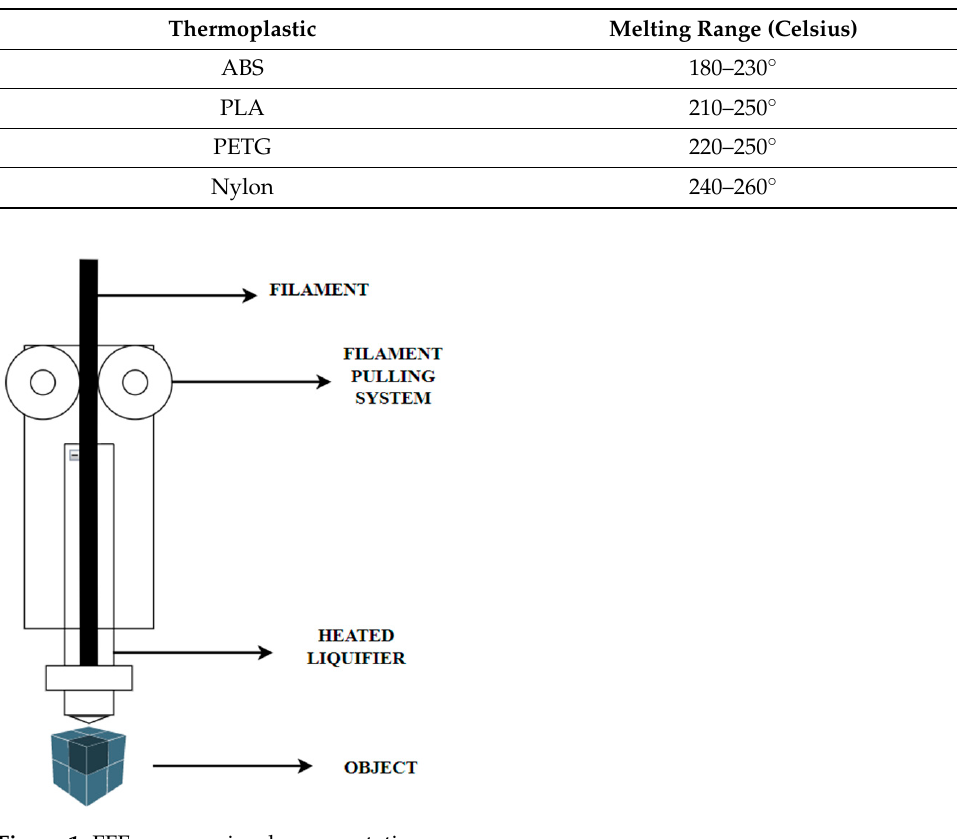
Figure 1. FFF process visual representation .